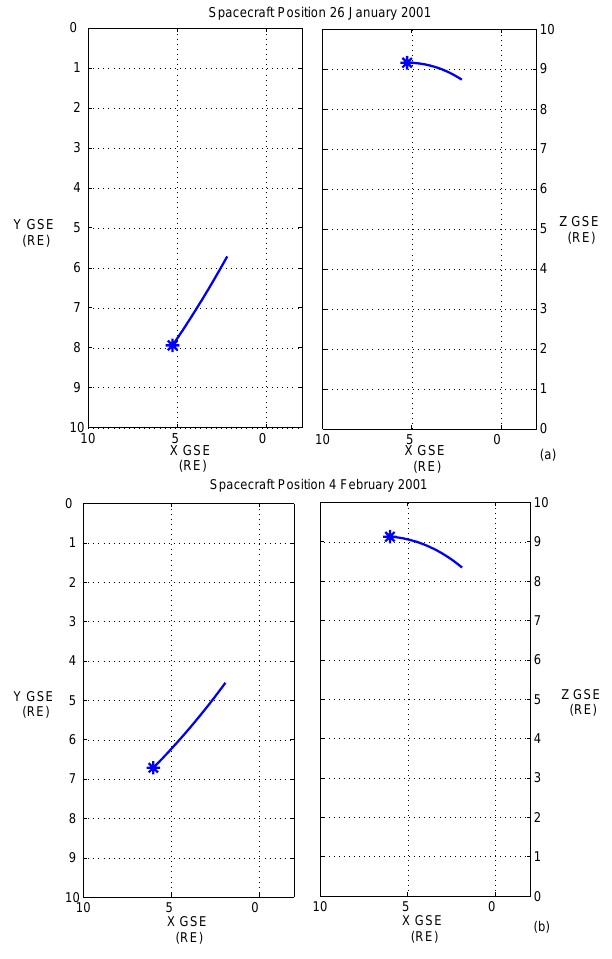
Fig. 1. The orbit position of the Cluster quartet for the two cases presented in this paper. The plots are in GSE coordinates with the Sun to the left. The star represents the end of the time period.